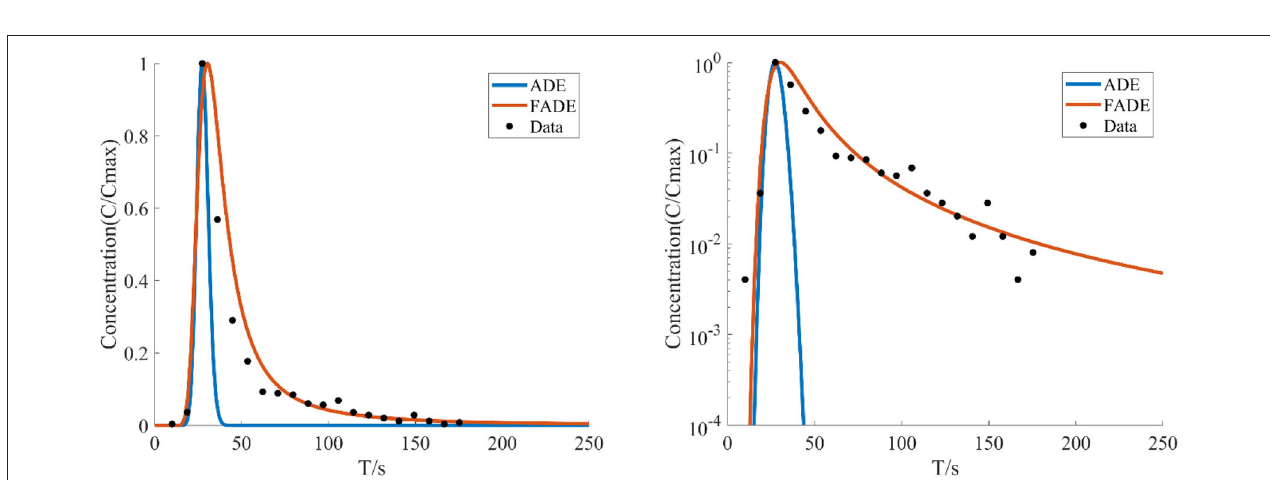
FIGURE 4 | The average flow rate is v = 26.962 mm/s, the crack width is B = 4mm, the BTCs are fitted by ADE model and FADE model.